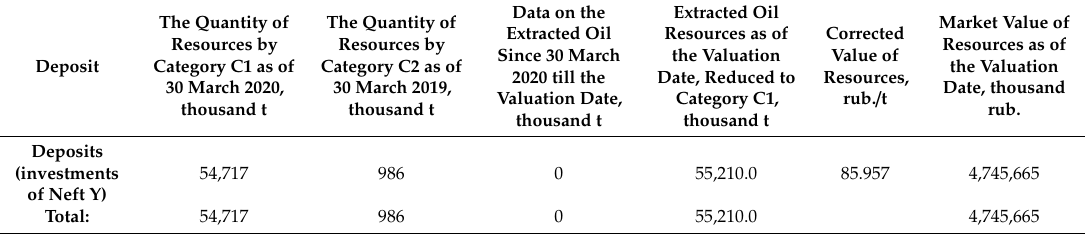
Table 7. The results of the calculated market value of the